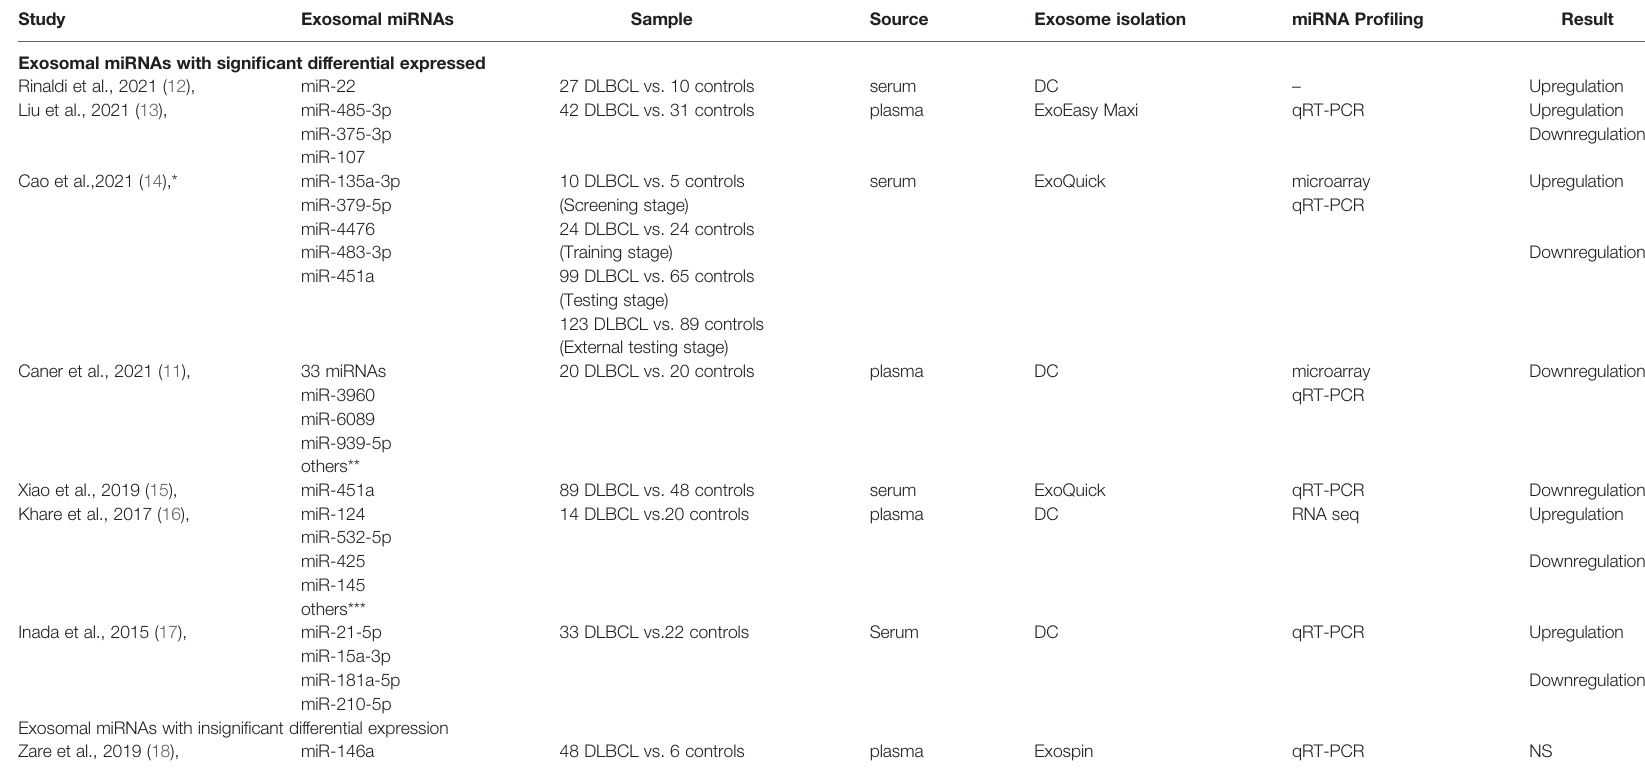
TABLE 3 | Exosomal miRNAs as diagnostic biomarkers in